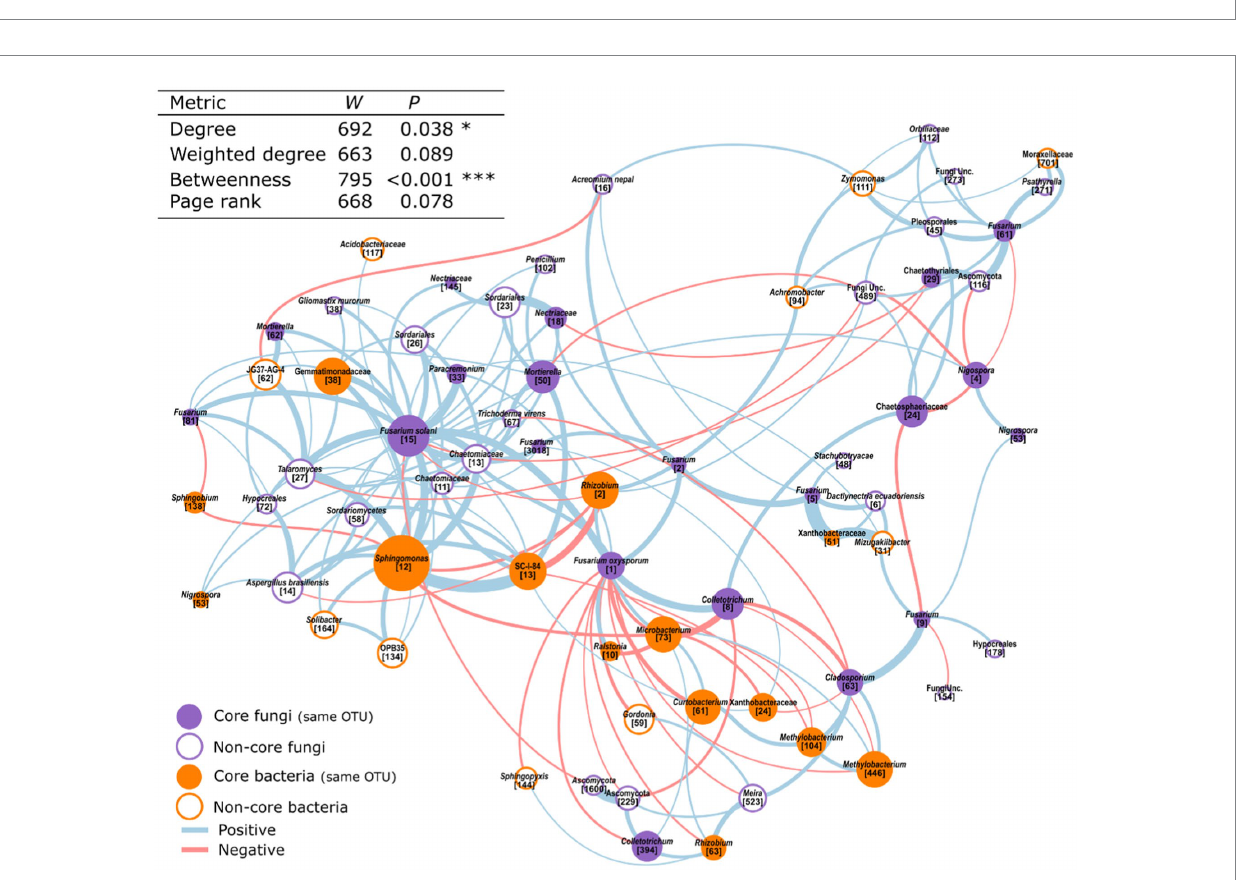
FIGURE 6 A subset of a dual amplicon co-occurrence network showing the interactions between Fusarium OTUs and their first order neighbours. Those that are core bacteria or fungi are highlighted. This network was created from the microbiome of 52 adult Musa spp. in a field setting. Node size is scaled by weighted